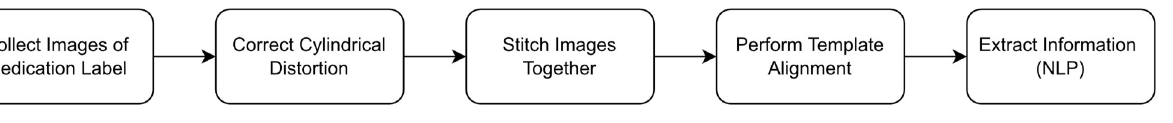
Figure 1. Study Approach